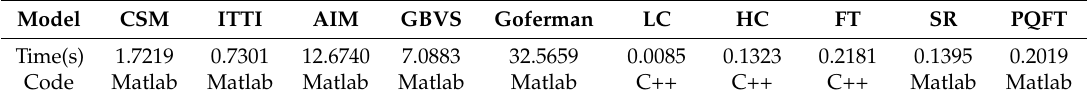
Table 1. Comparison of the computational